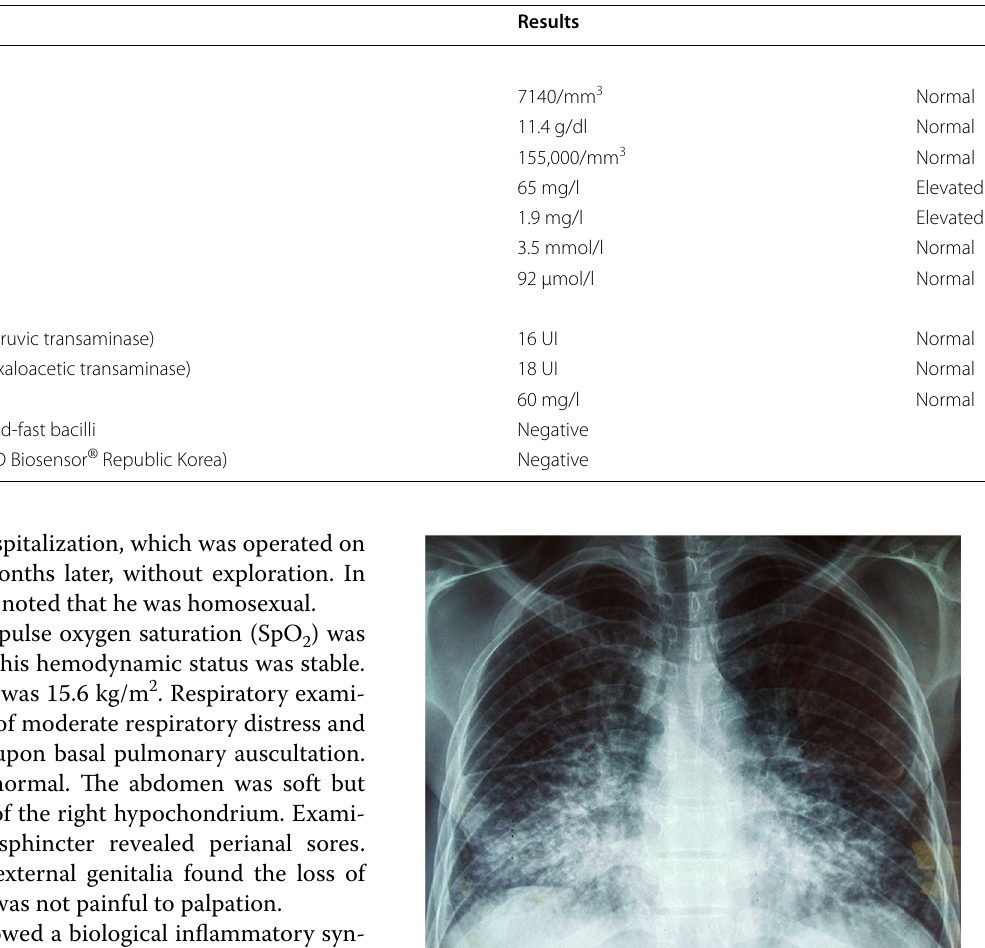
Fig. 1 Front view chest X-ray showing reticular-micronodular opacities in the hilar and basal pulmonary regions